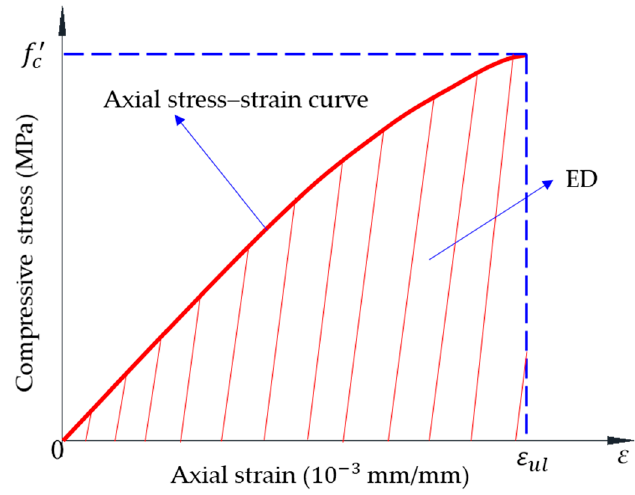
Figure 8. Definition of the energy absorption capacity.